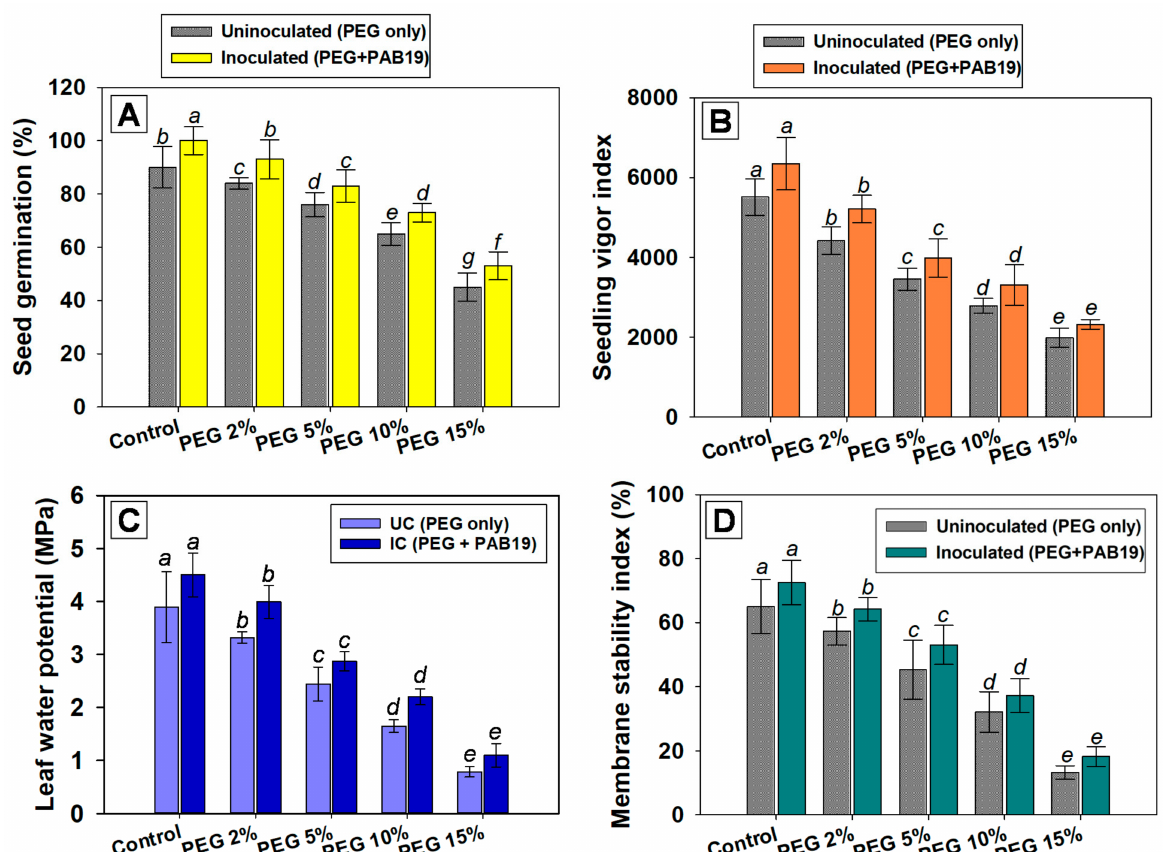
Figure 3. Germination efficiency ( A ), seed vigor indices ( B ), leaf water potential ( C ), and membrane stability indices ( D ) of V. radiata (L.) cultivated under different levels of water stress (2%, 5%, 10% and 15% PEG-6000) and inoculated with drought-tolerant Enterobacter sp./ L. adecarboxylata PAB19 under green-house conditions. Bar diagrams and curves represent the mean values of experiments done in triplicate. Mean values followed by different letters are significantly different at p ≤ 0.05 as determined by the DMRT. Bar and scatter plots represent means ±